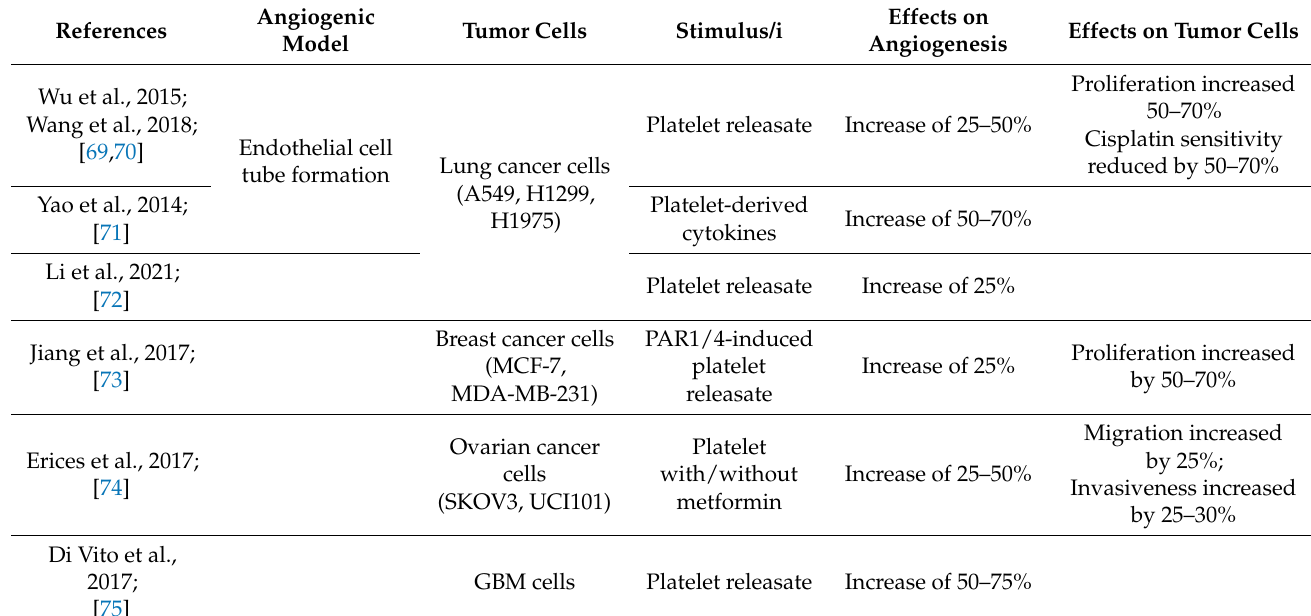
Table 1. Preclinical evidence of platelets involvement in tumor progression, mediated by angiogenesis, on in vitro